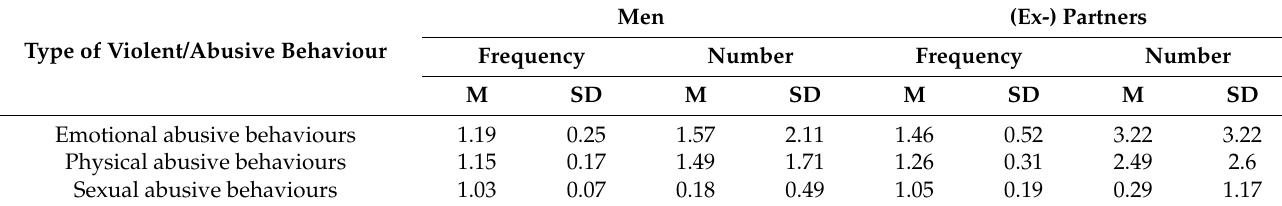
Table 3. Frequency and number of violent behaviours reported by men and (ex-) partners. Men (Ex-) Partners Type of Violent/Abusive Behaviour Frequency Number Frequency Number M Emotional abusive behaviours